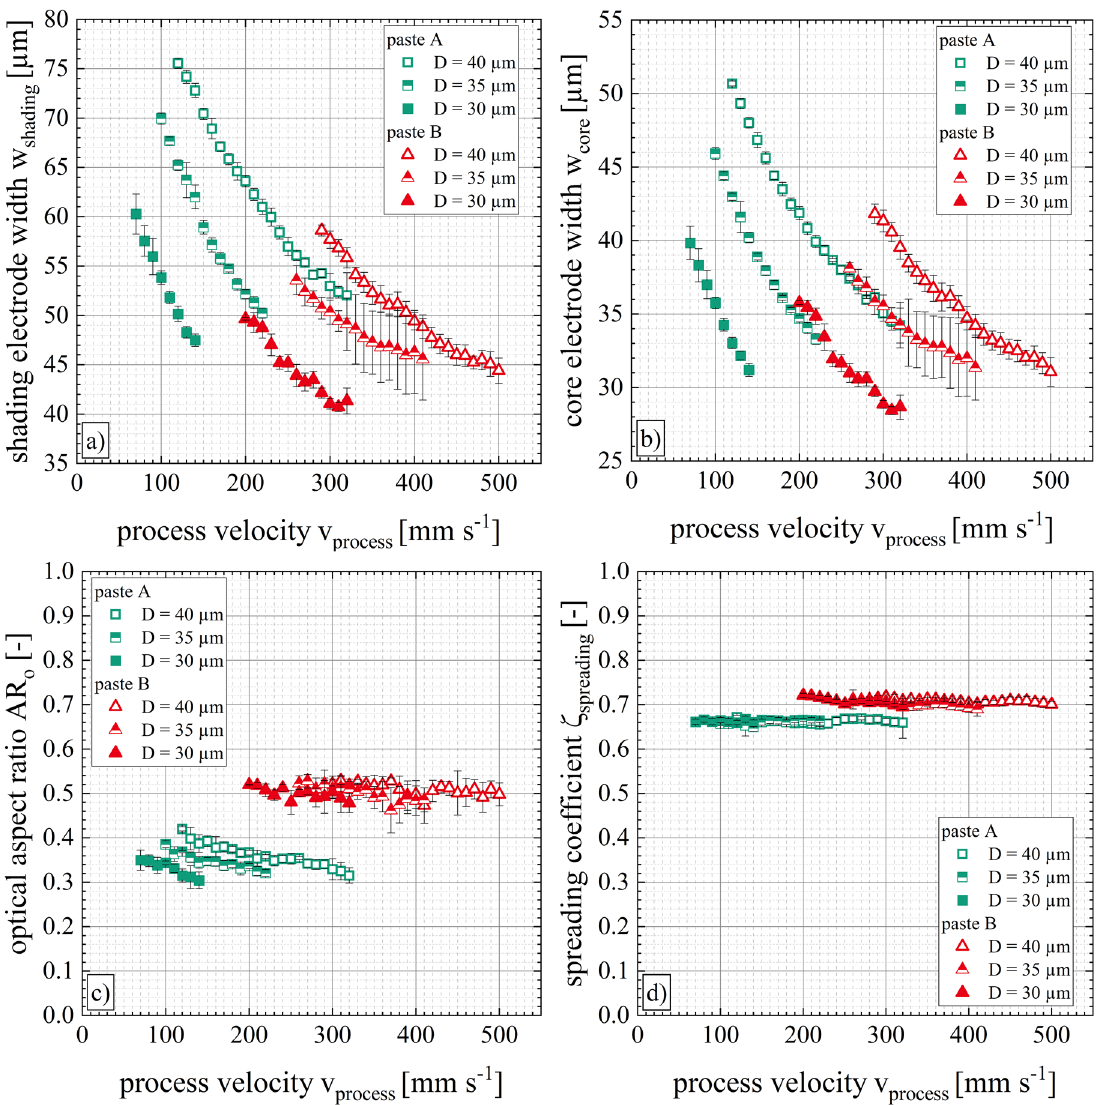
Figure 8. Ag-electrode shapes depending on homogeneous process velocities of category II for low- temperature curing Ag pastes A and B. The changes of ( a ) shading electrode width w shading , ( b ) core electrode width w core , ( c ) optical aspect ratio AR o , and ( d ) spreading coefficient ζ spreading are depicted exemplarily for nozzle openings of D = 40 µm, D = 35 µm and D = 30 of category II enables the reduction of the line electrode width as increasing process velocities result in decreas- ing core electrode widths as well as shading electrode widths. Using a smaller nozzle diameter helps to reduce the Ag-electrode width at the expense of significantly limiting the applicable process velocity while causing potential problems in process stability due to clogging of those nozzles because of the paste’s tendency to form agglomerates. In addition, smaller nozzle openings can encourage the paste spreading depending on the paste system. Nevertheless, dispensing low-temperature curing Ag pastes through small nozzle diameters results in the narrowest line electrodes. Further, we have evaluated the Ag laydown per 156.75 mm line in relationship to the process velocity in category II (Table 1). For example, extruding paste A through nozzle openings of D = 45 µm results in a Ag laydown of m Ag,paste-A = (1.90 ± 0.10) mg electrode −1 , when using the minimal process velocity of v process,min = 140 mm s −1 . Increasing the process velocity up to v process,max = 410 mm s −1 results in a decrease of paste laydown down to m Ag,paste-A = (0.71 ± 0.03) mg electrode −1 , following a delta reduction of Ag laydown by Δm Ag,paste-A =− 1.19 mg electrode −1 . The Ag saving potential of paste B in combination with nozzle diameters of D = 45 µm is only Δm Ag,paste-B = − 0.66 mg electrode −1 . Decreasing the nozzle diameter reduces the possible magnitude of Ag reduc- tion as paste A shows a Ag laydown between m Ag,paste-A = (0.85 ± 0.04) mg electrode −1 at v process,min = 70 mm s −1 and m Ag,paste-A = (0.55 ± 0.03) mg electrode −1 at v process,min = 140 mm s −1 for 30 µm nozzle openings. Thus, filament stretching enables the control of Ag laydown per solar cell.